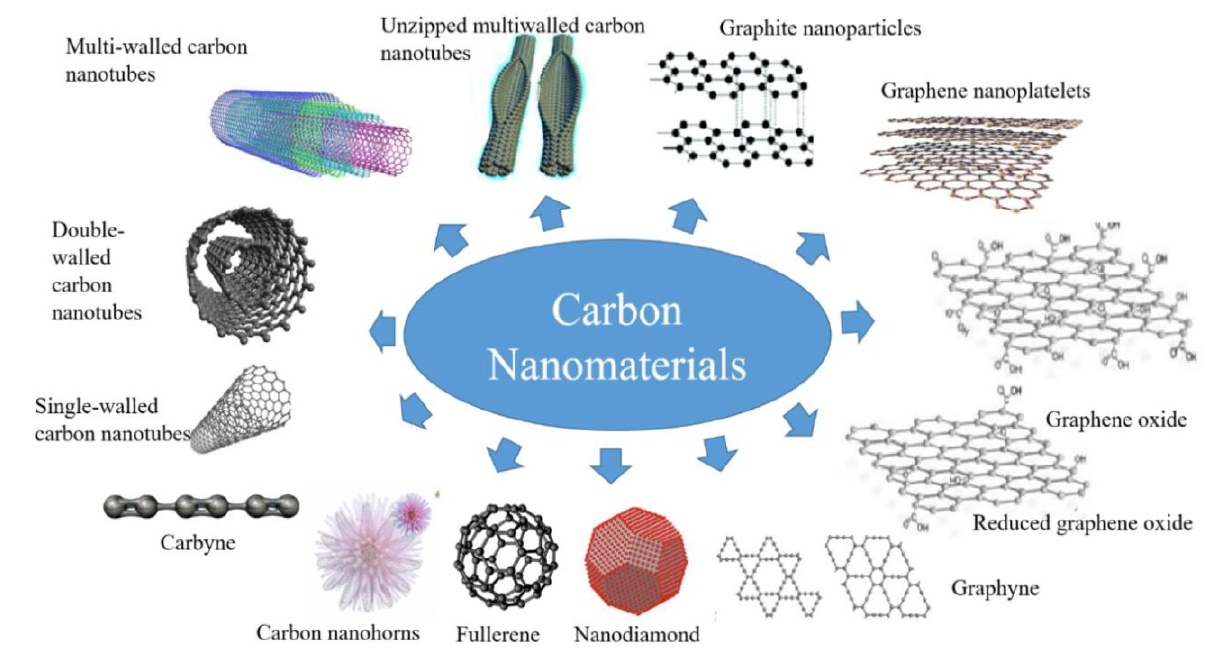
Figure 3. Common allotropes of carbon nanomaterials that grant distinctive thermophysical properties [50].